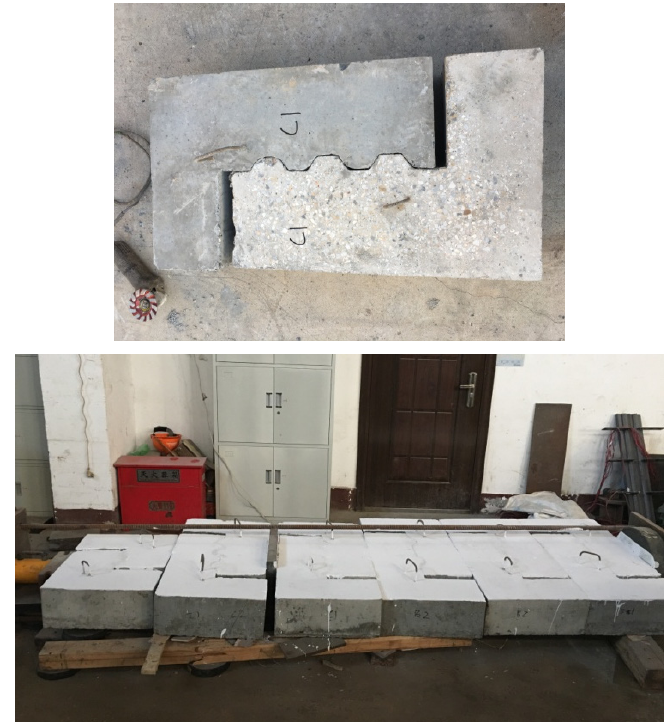
Figure 5. Installation process of the specimens.